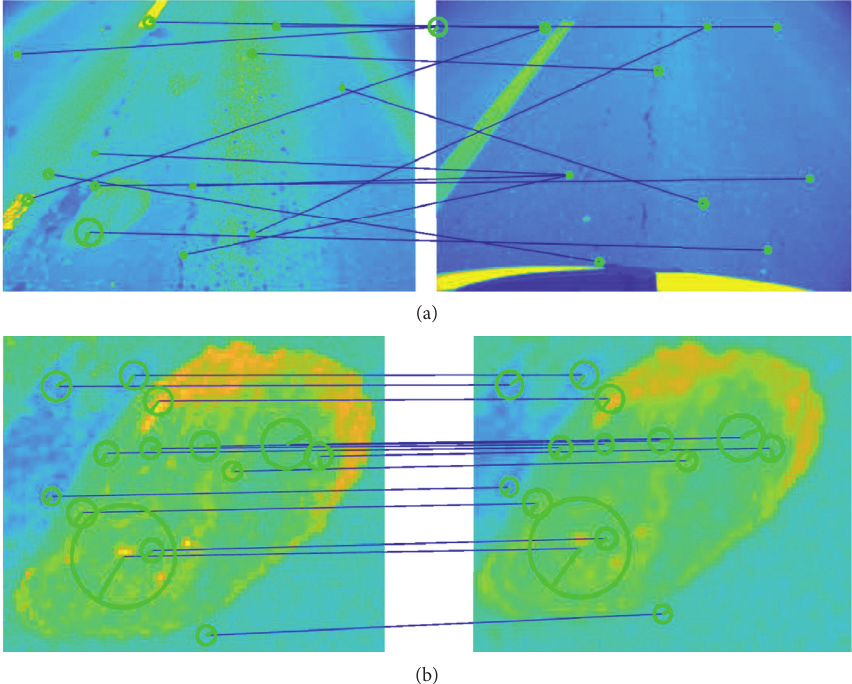
Figure 7: (a) The mismatched features. (b) SIFT feature matching with bounding